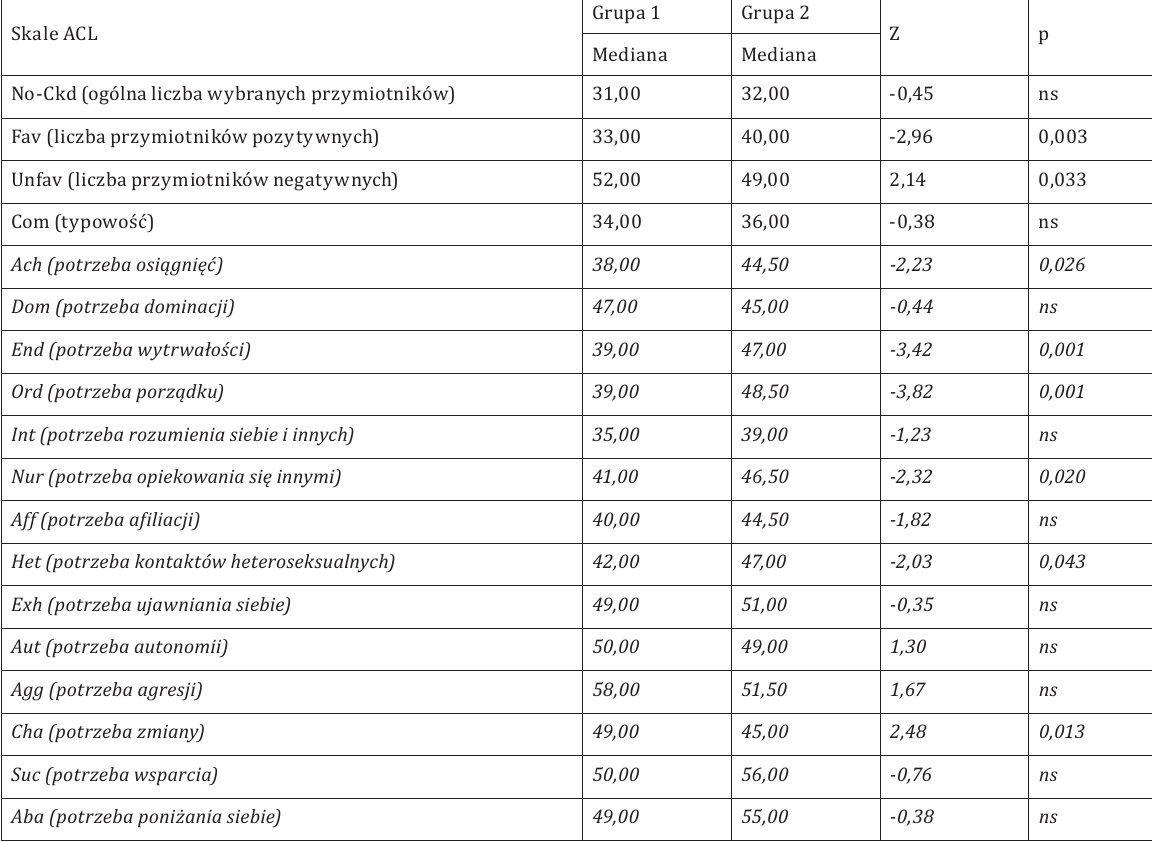
Dane zamieszczone w tabeli 2. informują, że osoby o wyższych indeksach nadużycia w dzieciństwie (Grupa